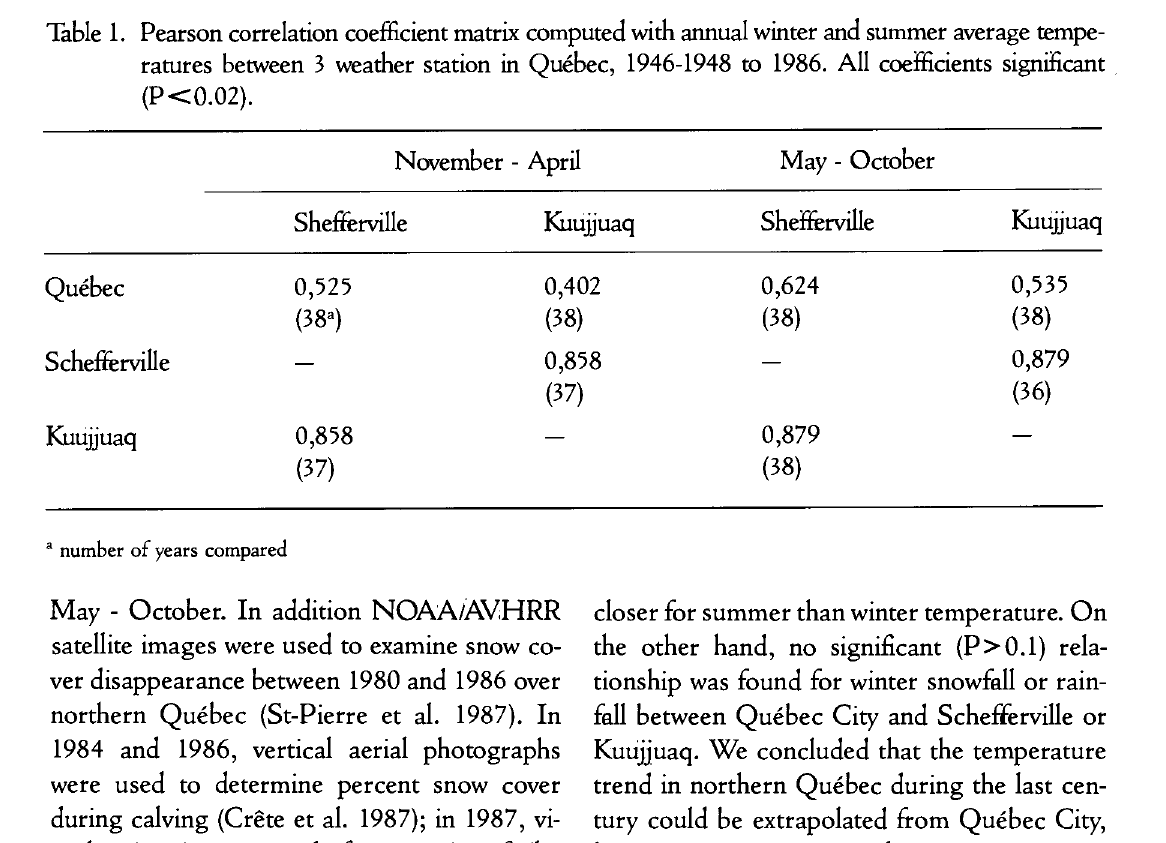
Table 1. Pearson correlation coefficient matrix computed with annual winter and summer average tempe ratures between 3 weather station in Québec, 1946-1948 to 1986. All coefficients significant (P<0.02).